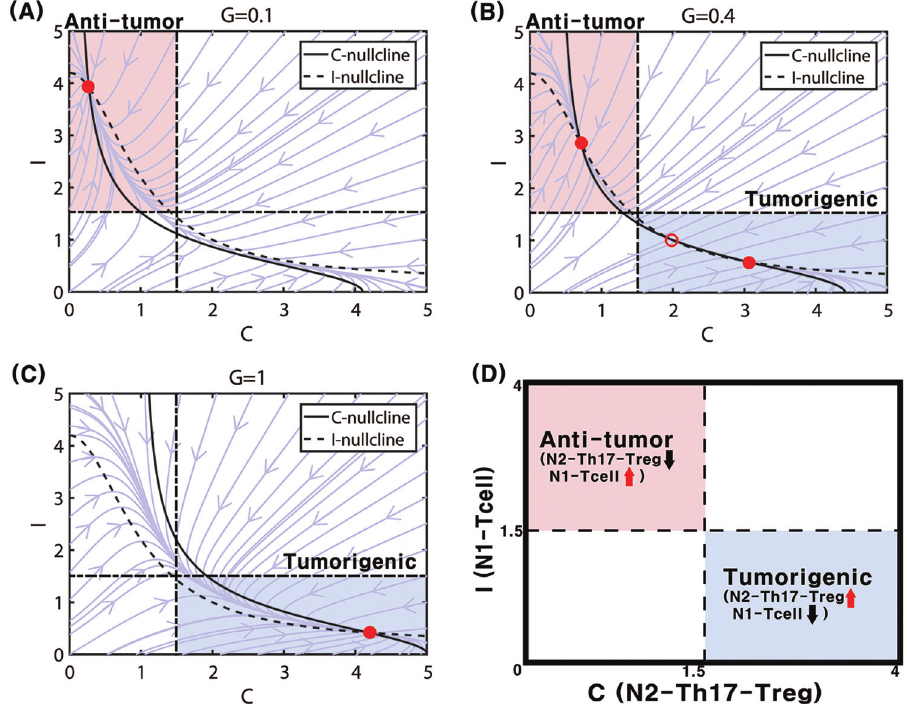
Fig 5. Nonlinear dynamics. Dynamics of the system (5) and (6) in the C-I phase plane in response to low ( G = 0.1 in (A)), intermediate ( G = 0.4 in (B)), and high ( G = 1.0 in (C)) levels of TGF- β -induced transition signals. Steady states marked with circles (stable steady state = filled circle, unstable steady state = empty circle). (D) A schematic of anti- tumorigenic ( C < C th , I > I th ) and tumorigenic ( C > C th , I < I th ) regions in the C − I plane. S = 0.2 fixed. Other parameters are given in Table